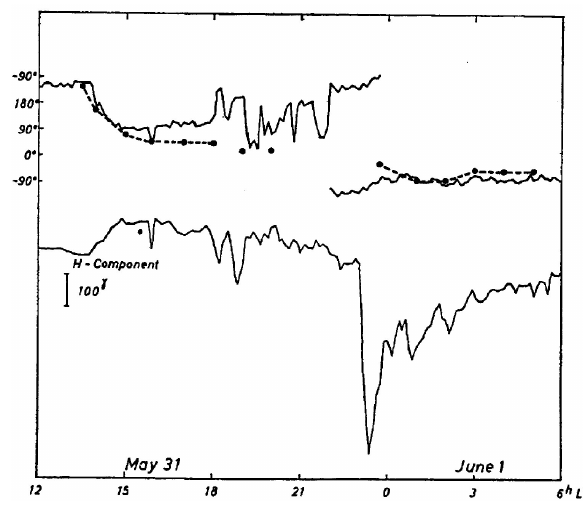
Figure 16. Comparison between directions of ionospheric current and lower boundary of aurora (Oguti, 1960).